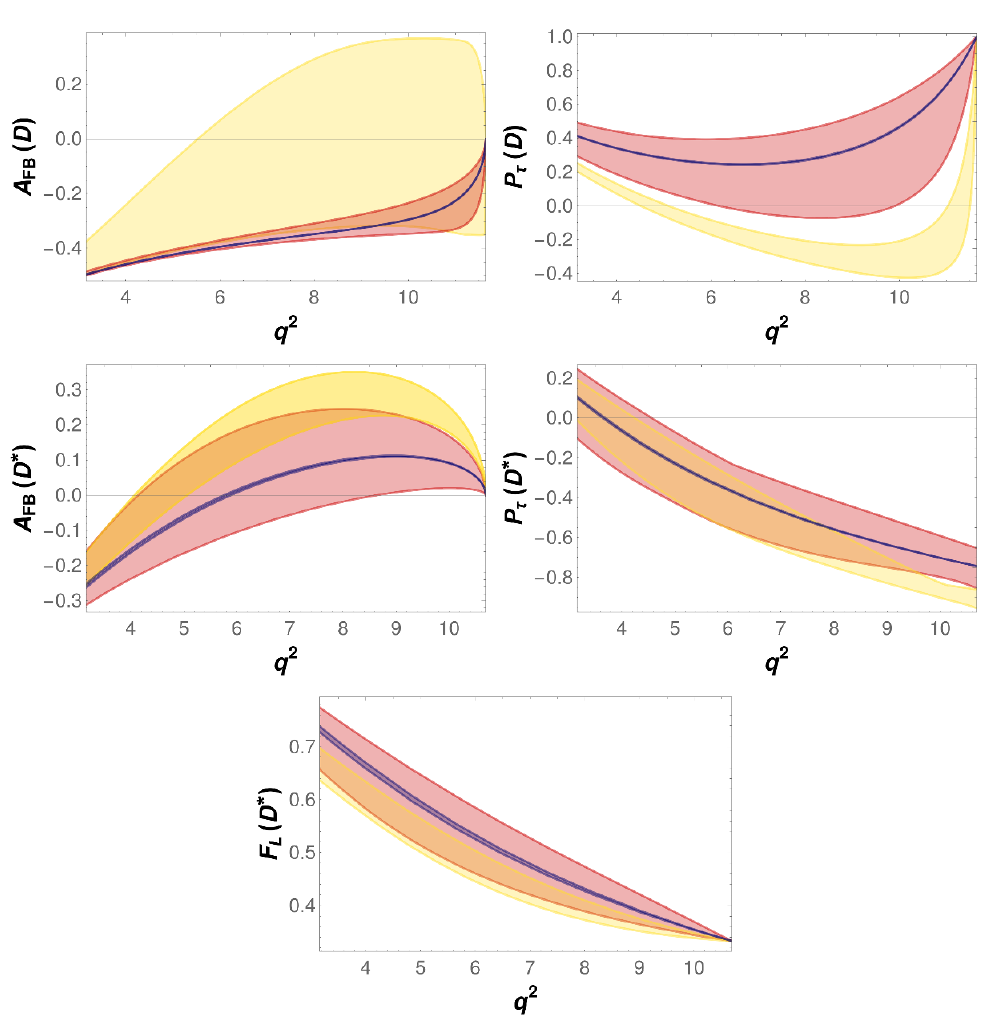
Figure 10 . Predictions and 1 (cid:27) uncertainty on the q 2 dependence of the B for the solutions of the (cid:12)t including the Moriond result and F D (cid:3) (cid:28) (cid:22) (cid:23) (cid:28) ) 30% has been adopted. The predictions of Min 1b, Min 2b and the SM are represented by (cid:20) a red, yellow and blue band,